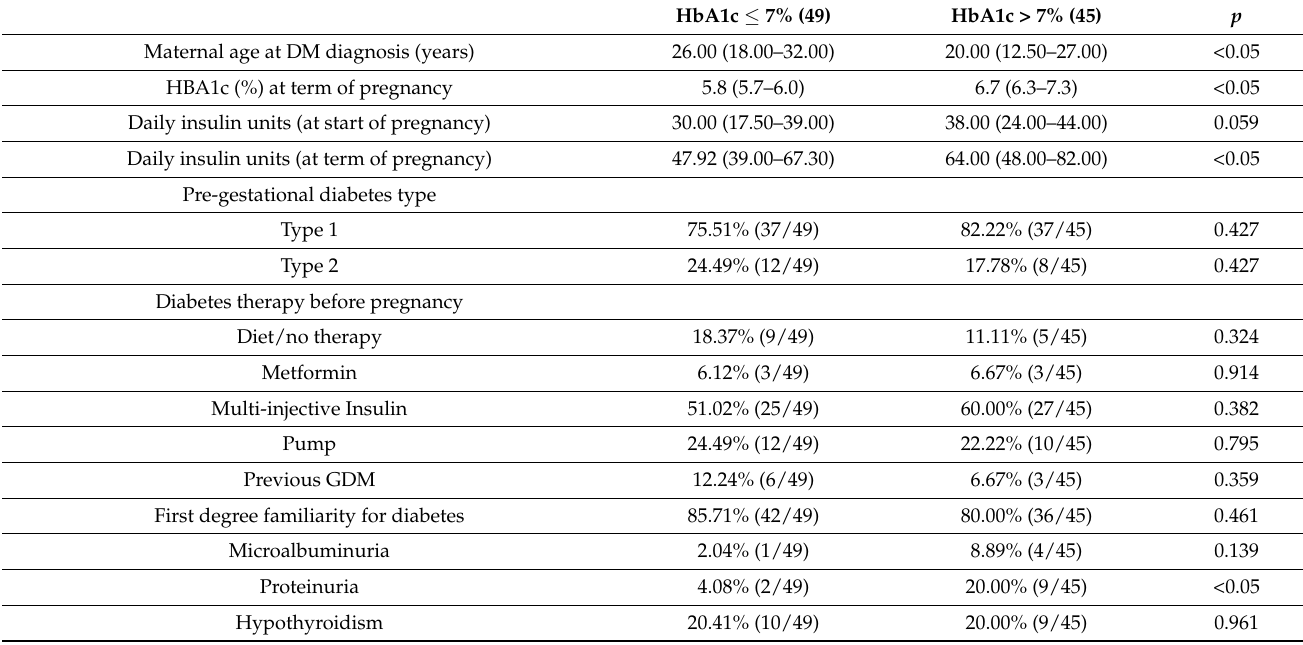
Table 2. Differences between the two groups of women with pre-gestational diabetes throughout the course of the disease during